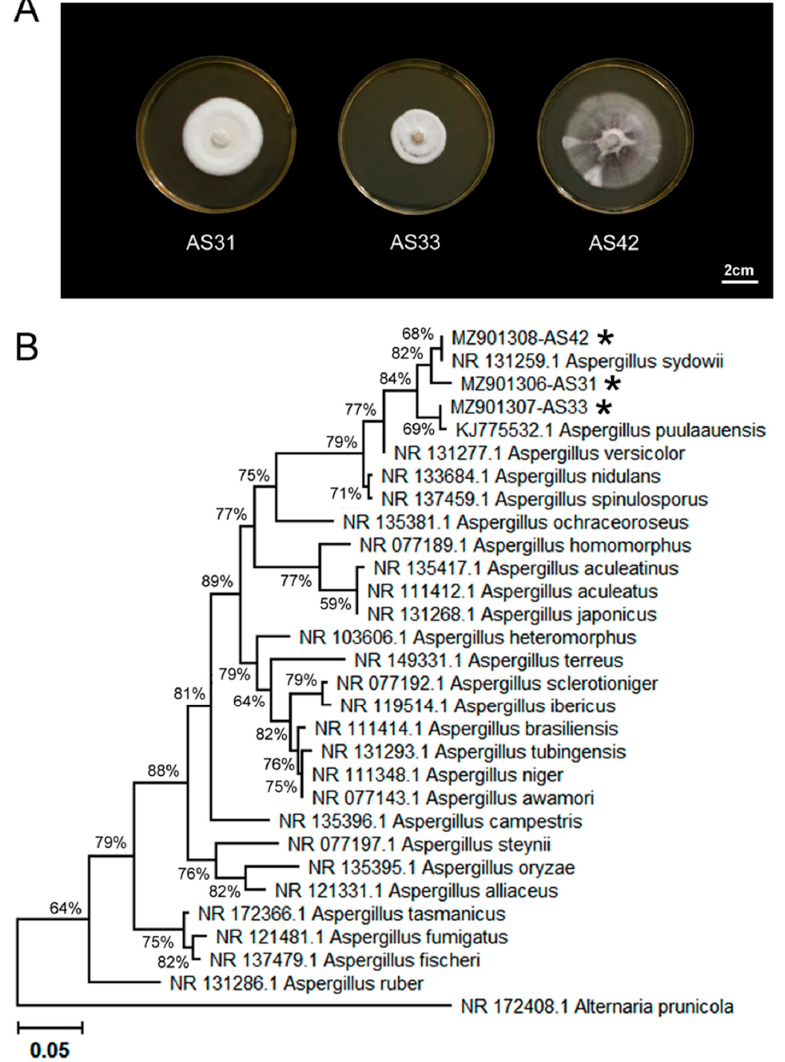
Figure 1. Identification of strains AS31, AS33, and AS42. ( A ), Colony morphology of the three strains isolated from the roots of healthy Phytolacca americana L. ( B ), Phylogenetic relationships between the three strains and related species showing the position of strains AS31, AS33, and AS42 within the genus Aspergillus . The maximum likelihood (ML) phylogenetic tree is shown. The ML bootstrap values based on 1000 replications are indicated above the branches. Asterisks indicate the strains isolated in this study. Bar, 0.05 substitutions per nucleotide position.